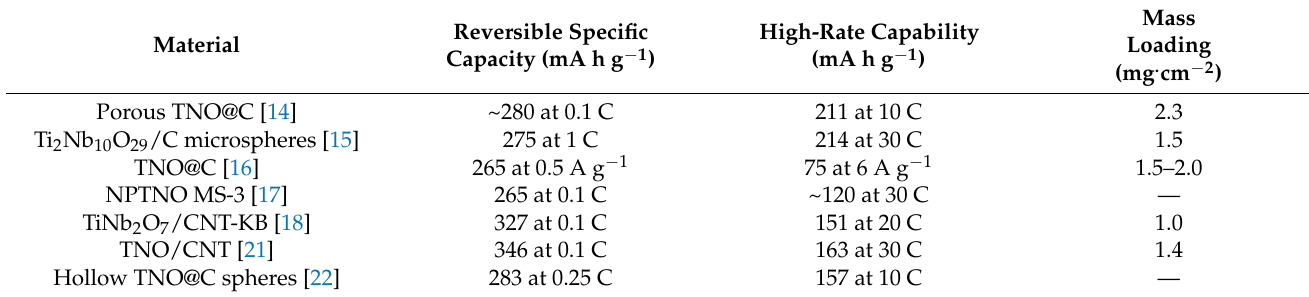
Table 1. The summarization of TNO anode materials and their